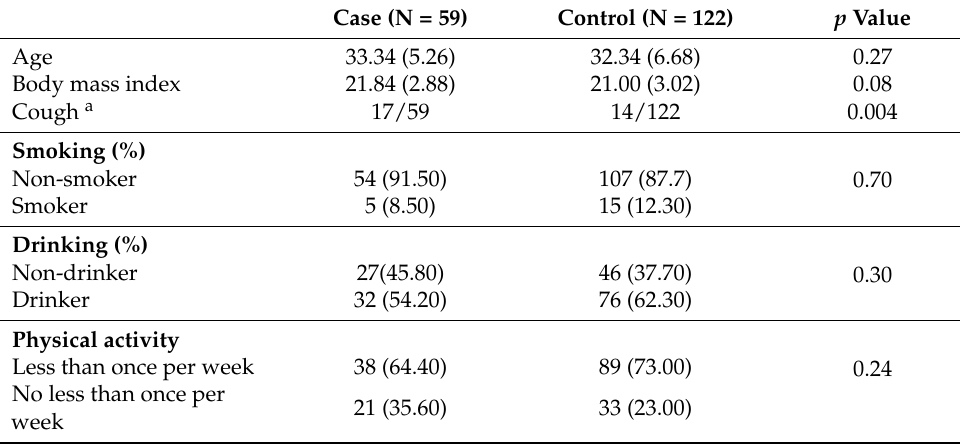
Table 1. Characteristics of participants by their house cleaning